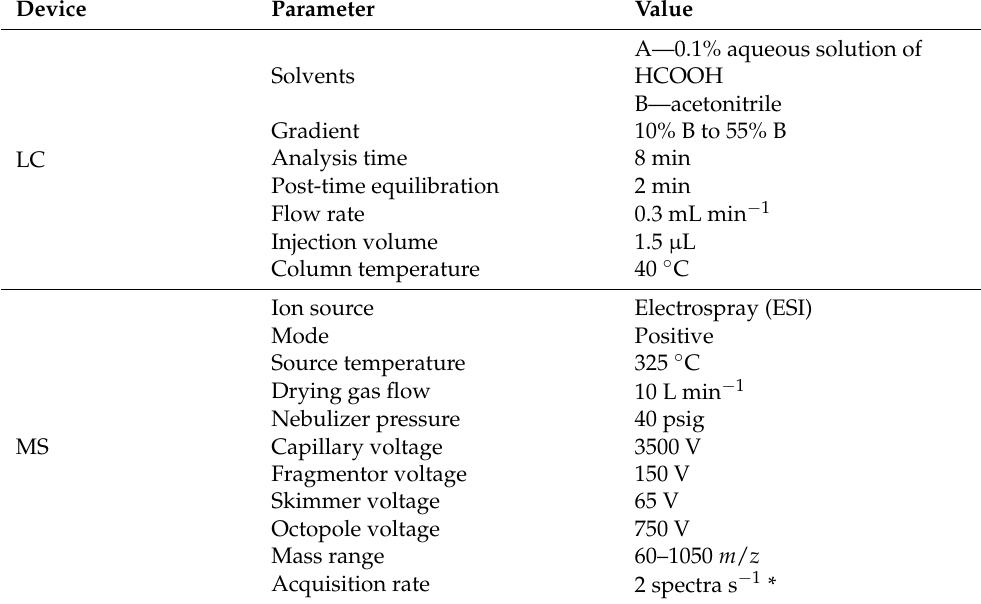
Table 3. LC–MS parameters.